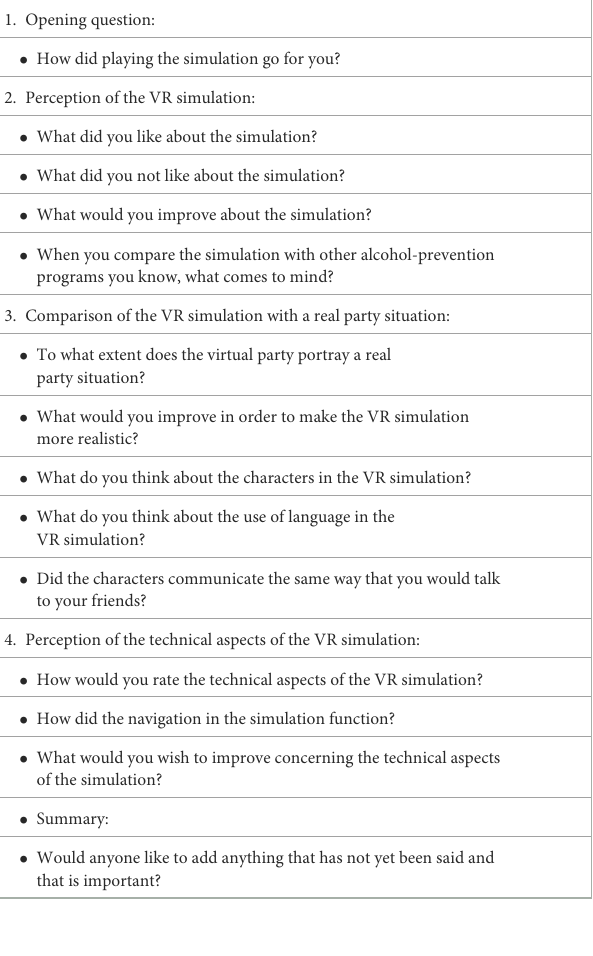
TABLE 2 Guide for the focus group